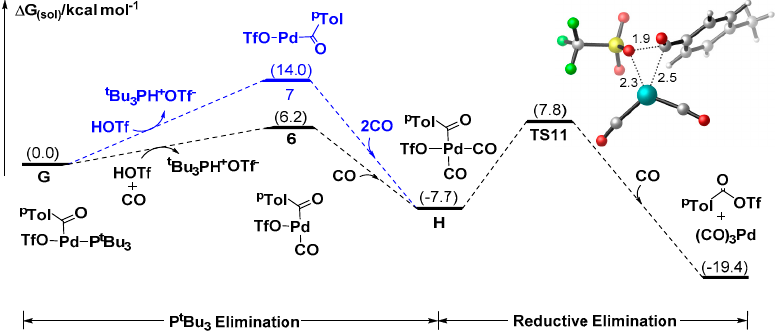
Figure 7. Calculated reaction potential energy surface of sequestrating P t Bu 3 to generate aroyl triflate in presence of HOTf and